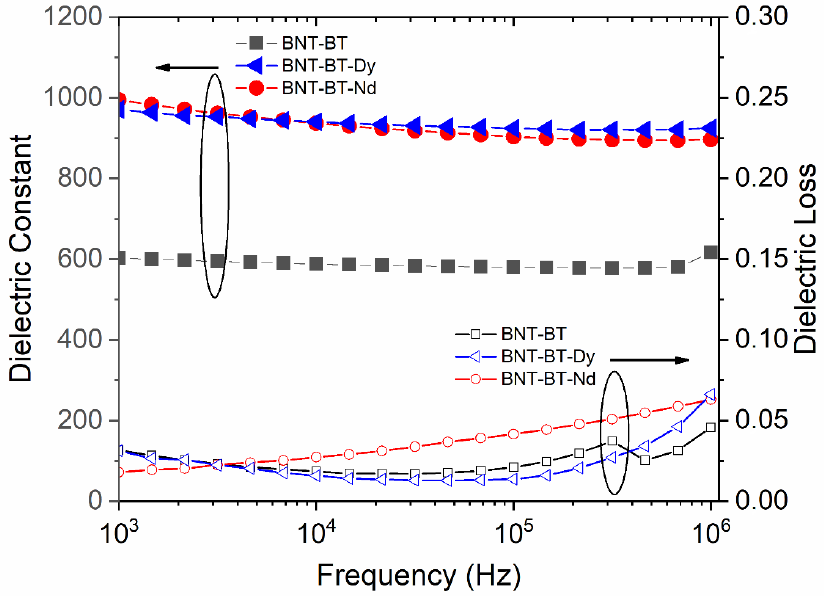
Figure 4. Room-temperature frequency dependence of the dielectric constants and the dielectric losses for the investigated samples.